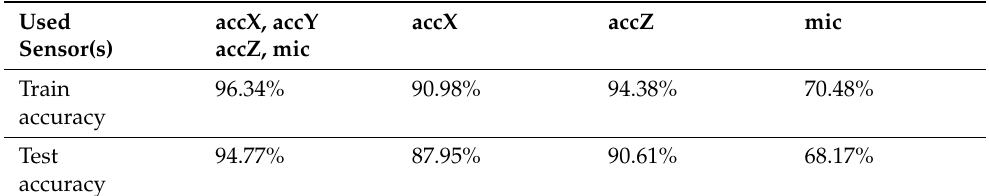
Table 2. Acuracy of the conventional LSTM model (one LSTM-layer).